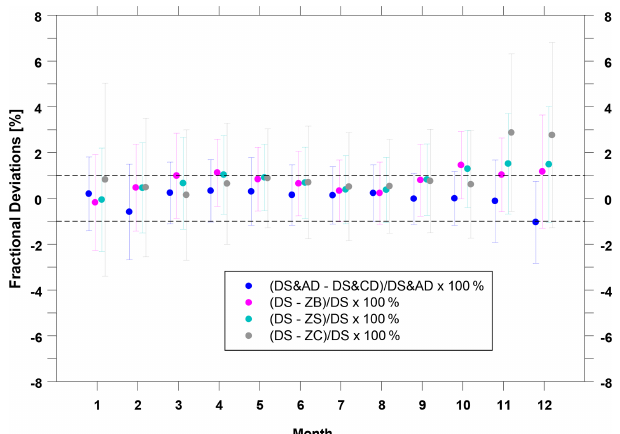
Figure 4. The monthly mean relative differences between daily TCO 3 means derived from different types of the Dobson measure- ments. The bar denotes the range: mean ± standard